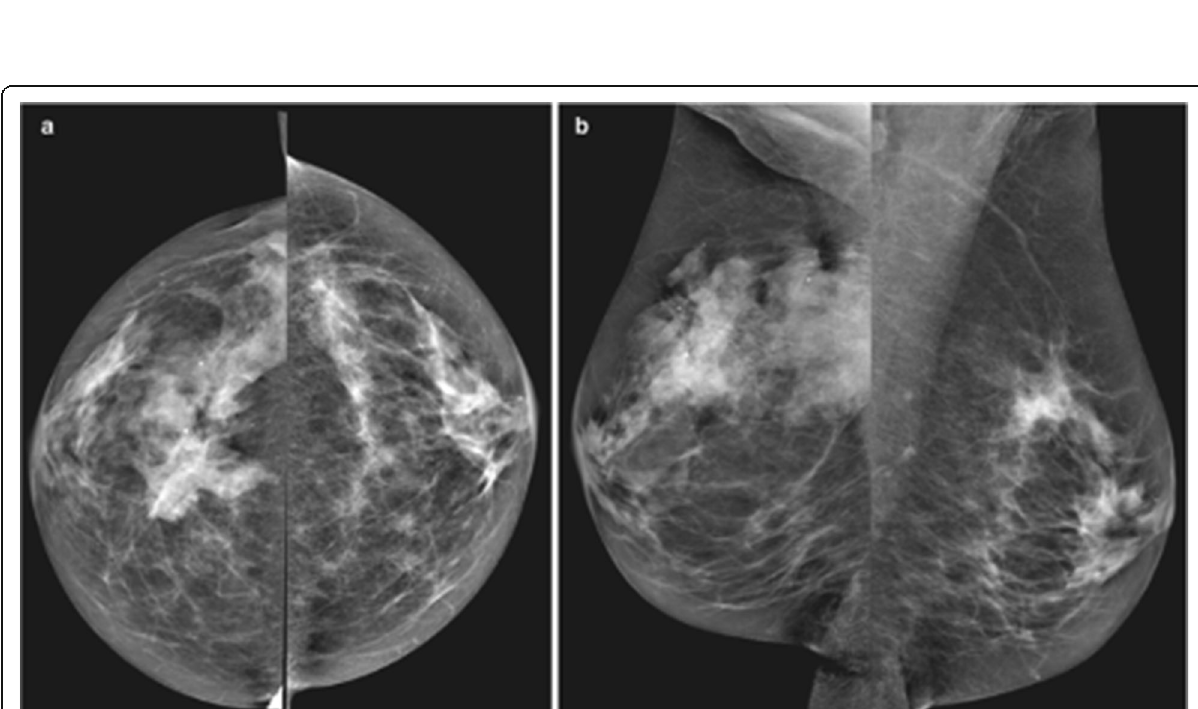
Fig. 2 Mammogram of ductal carcinoma in a 72-year-old woman. a CC view. b MLO view